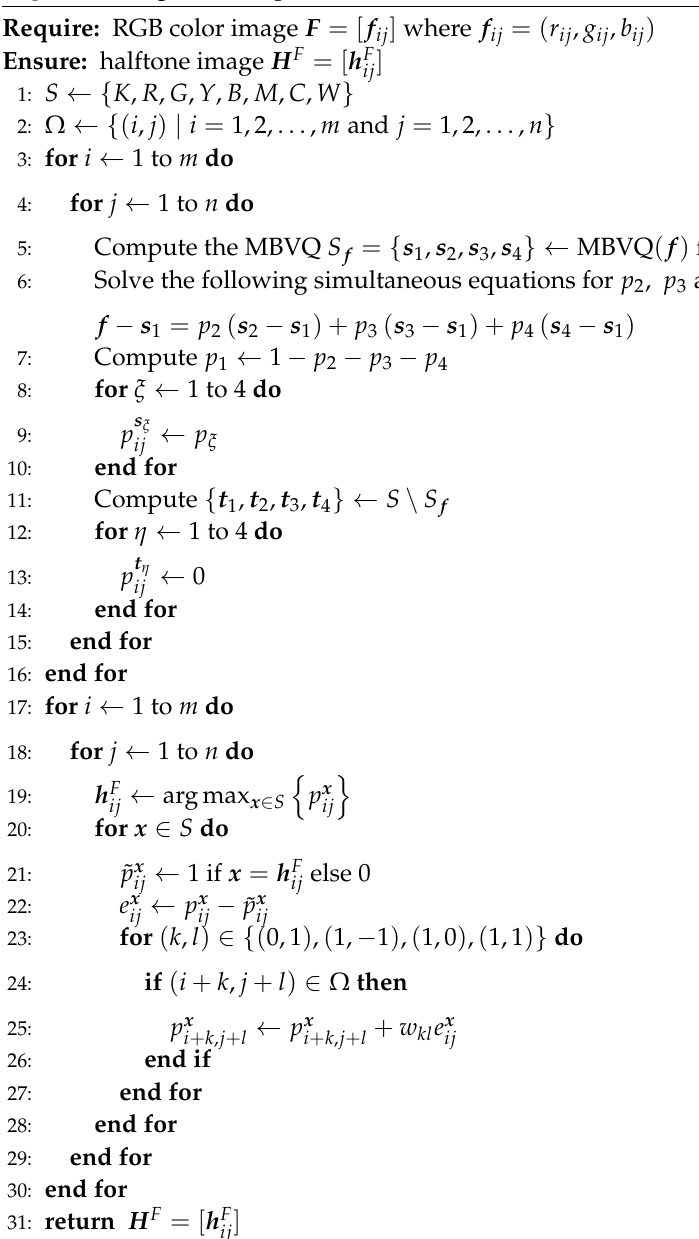
Algorithm 2 Sparse Neugebauer model-based error